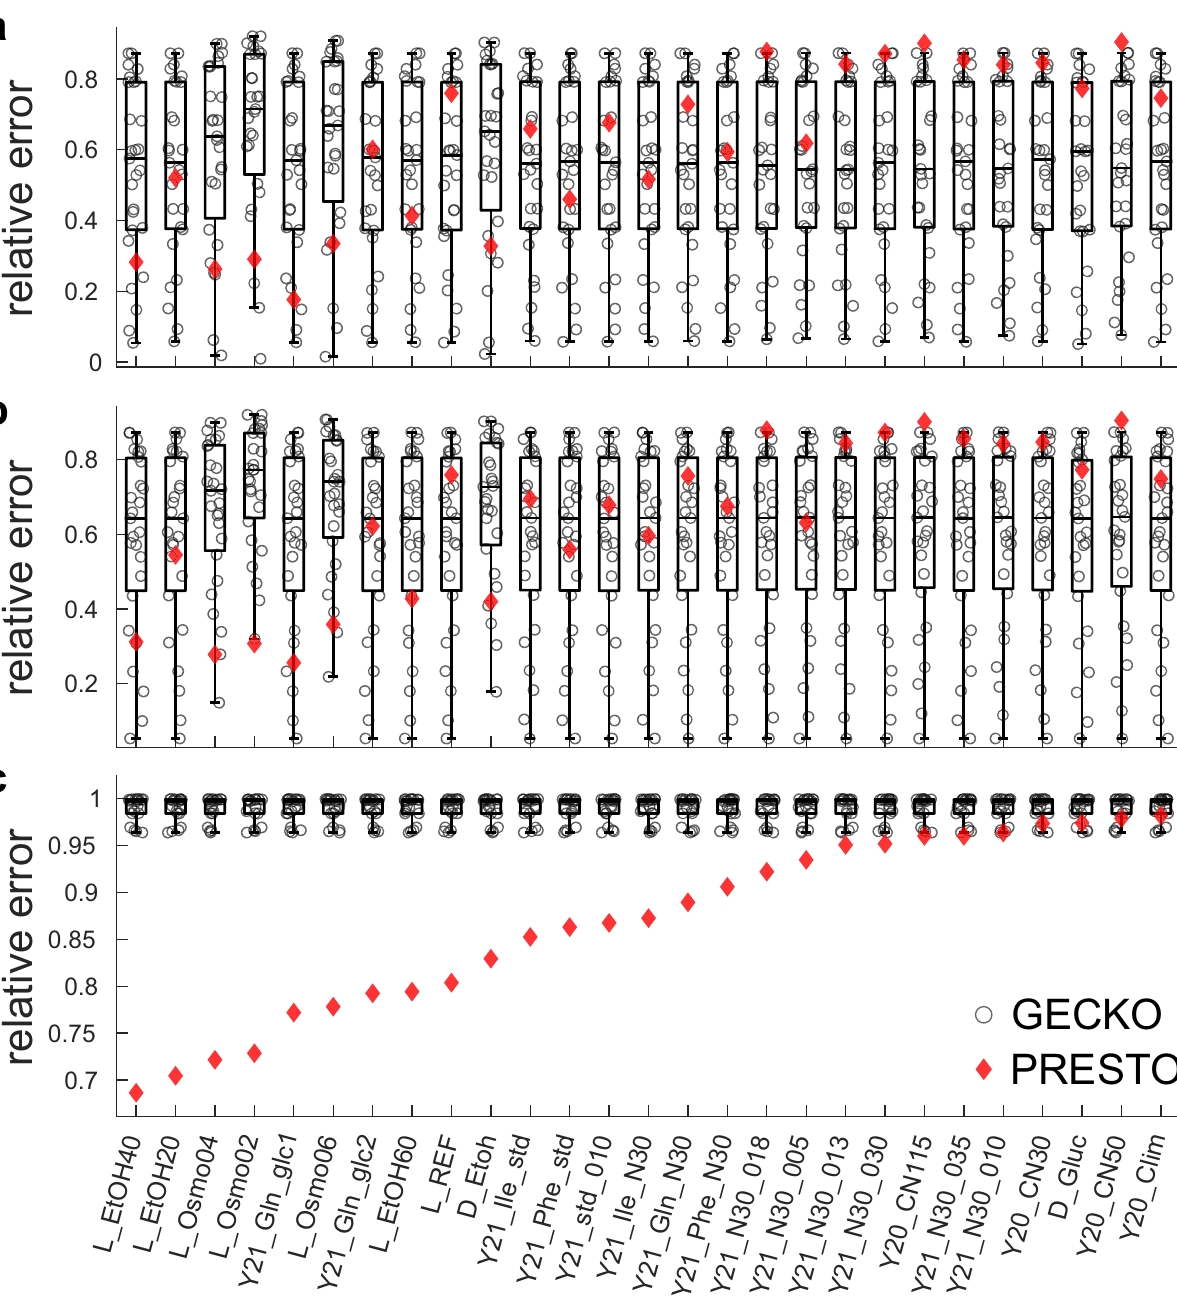
; b measured uptake rates were also considered; bounded by 1000 mmol hgDW c abundances of enzymes measured in all conditions were used as additional fi c constraints. The compared pcGEMs in each condition ( n =19) used the same respectivebiomassreaction,GAM, σ ,and P tot values(seethe “ Methods ” section).L: Lahtvee et al. 34 , D: DiBartolomeo et al. 37 , Y20:Yuet al. 35 , Y21:Yuet al. 36 . Middle line and boxes in the box charts in panels a – c indicate the median and 25th and 75th percentiles,respectively.Outliervalues(circlesoutsidethewhiskerrange)aremore than 1.5× the interquartile range away from the top or bottom of the box, and whiskers connect the lower or upper quartiles with the non-outlier minimum or maximum. Source data are provided as a Source Data fi